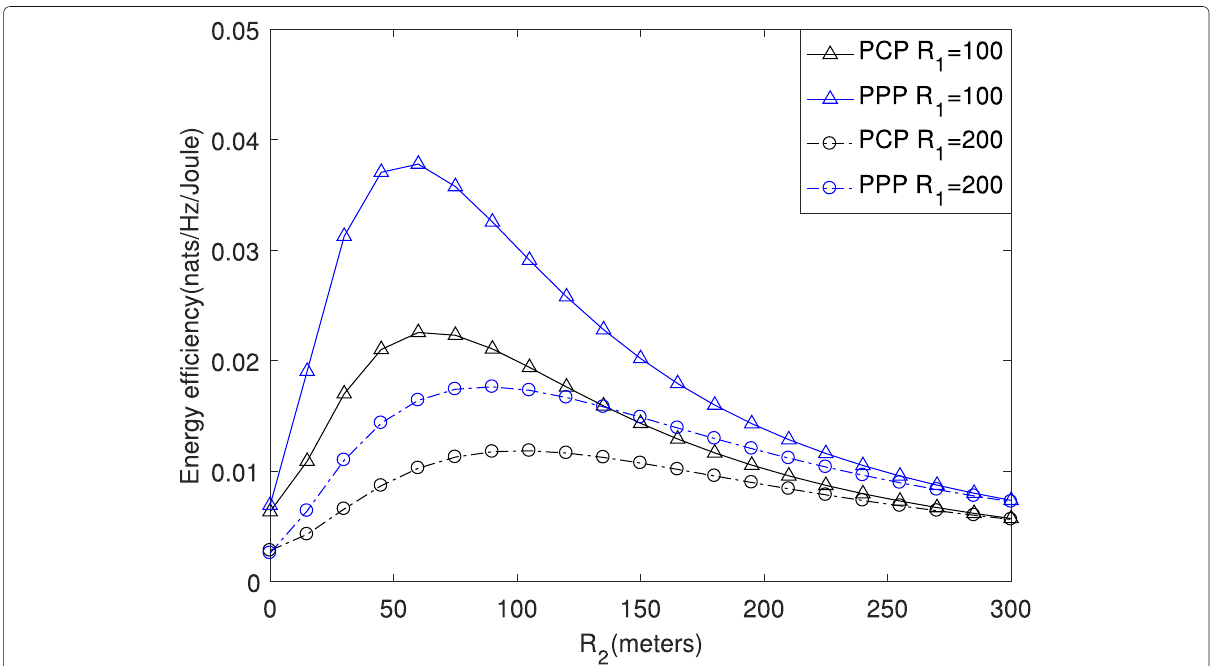
Fig. 6 The energy efficiency of a two-tier network as a function of the first-tier and the second-tier cooperative radius for PPP and